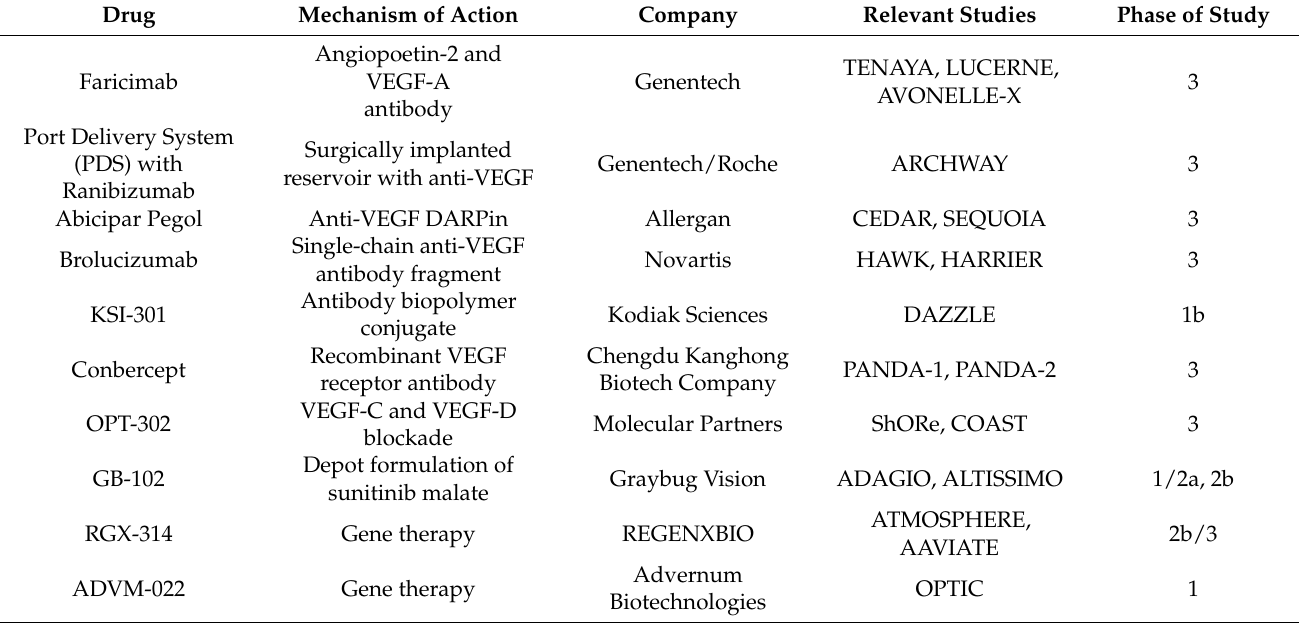
Table 1. Currently available and experimental treatments for neovascular age-related macular degeneration (nAMD). Drug Mechanism of Action Company Relevant Studies Phase of Study Angiopoetin-2 Faricimab